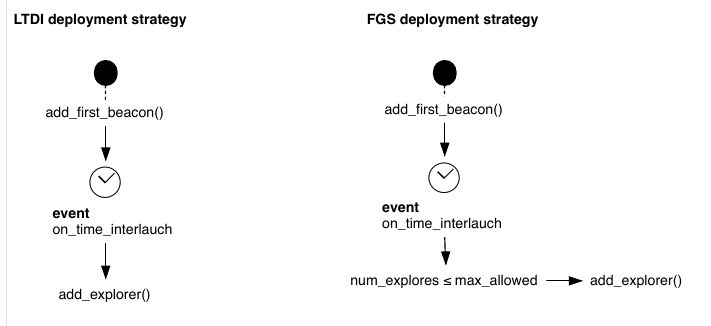
Figure 3. State diagram for each of the deployment strategies used in this article. Note that the linear-temporal incremental deployment (LTID) strategy is a special case of fixed group incremental deployment (FGID) when max_allowed equals the number of swarm